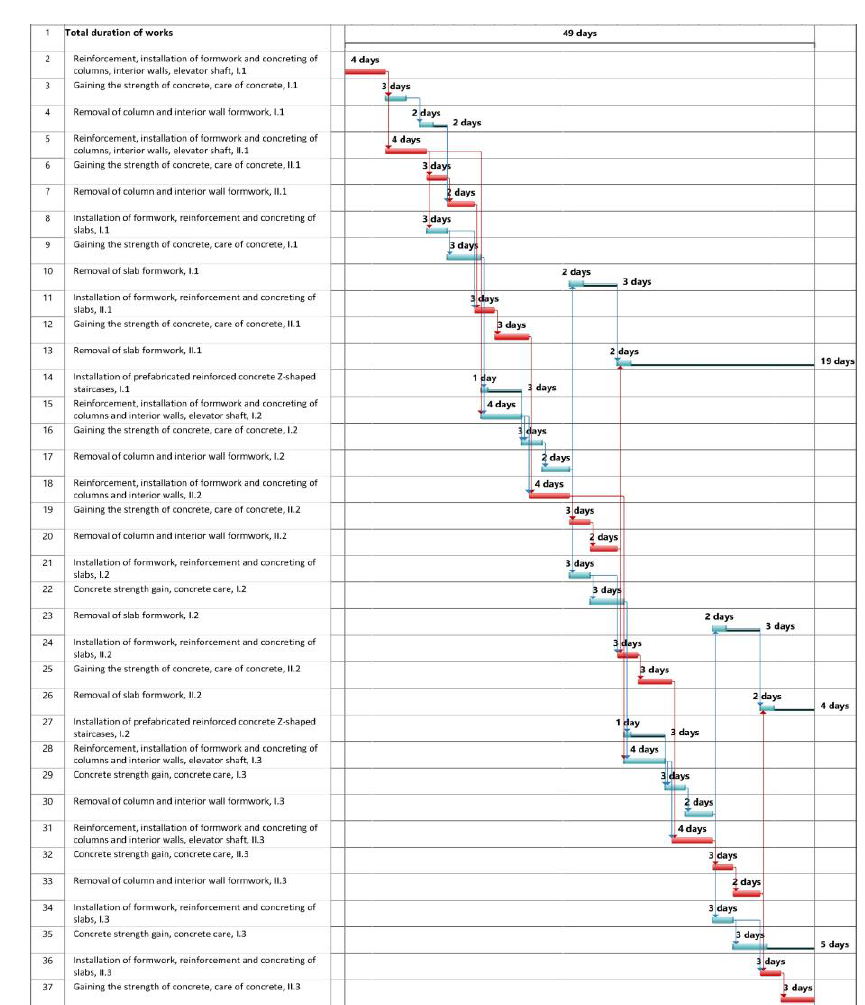
Figure 9. Schedule model No. 1 developed for the construction of a reinforced concrete building frame.